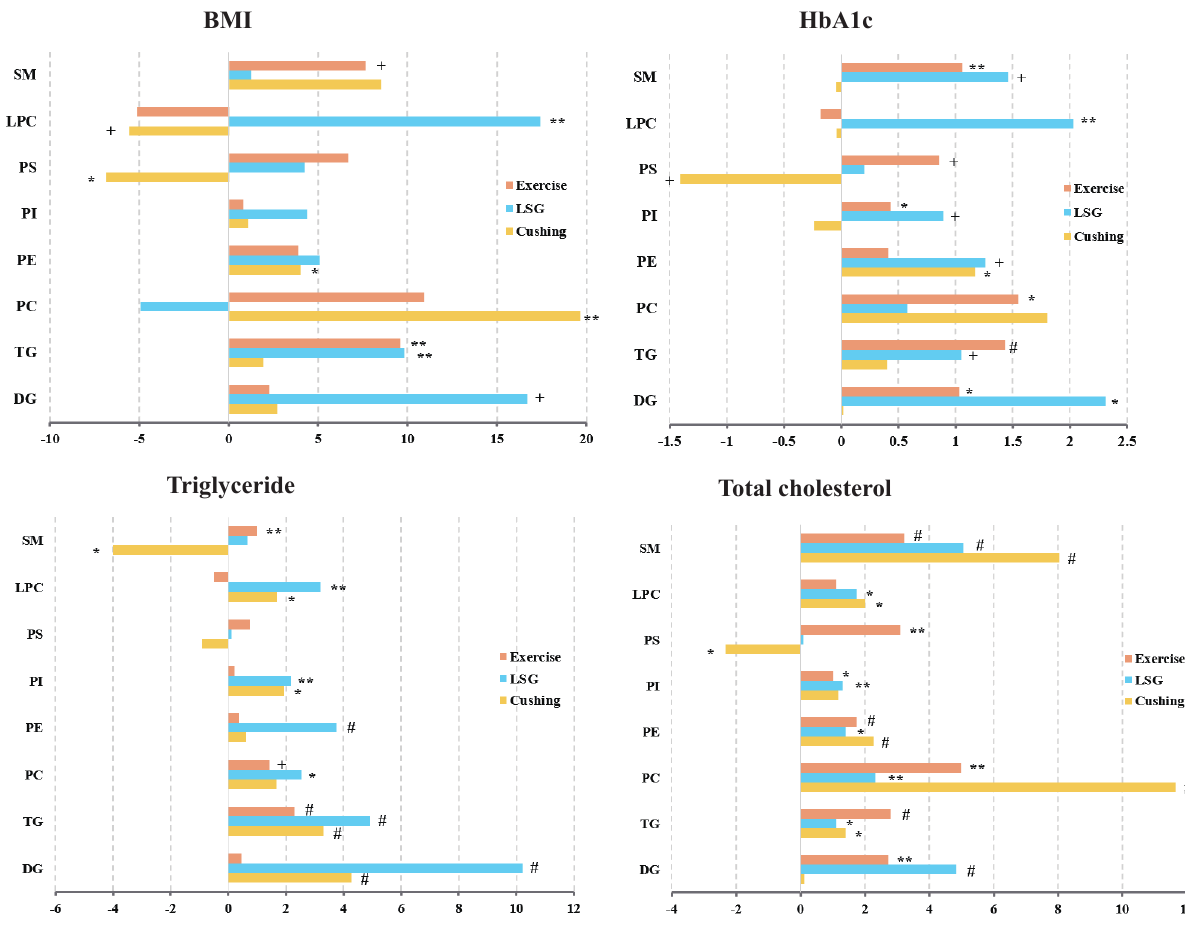
Figure 4. BMI, HbA1c, triglyceride, and total cholesterol were associated with lipidome. Percentage changes in total lipid species with increasing percent of BMI, HbA1c, triglyceride, and total cholesterol. Values calculated by linear regression analysis after logarithmic transformation of lipid data, + p < 0.1, * p ≤ 0.05, ** p ≤ 0.01, # p ≤